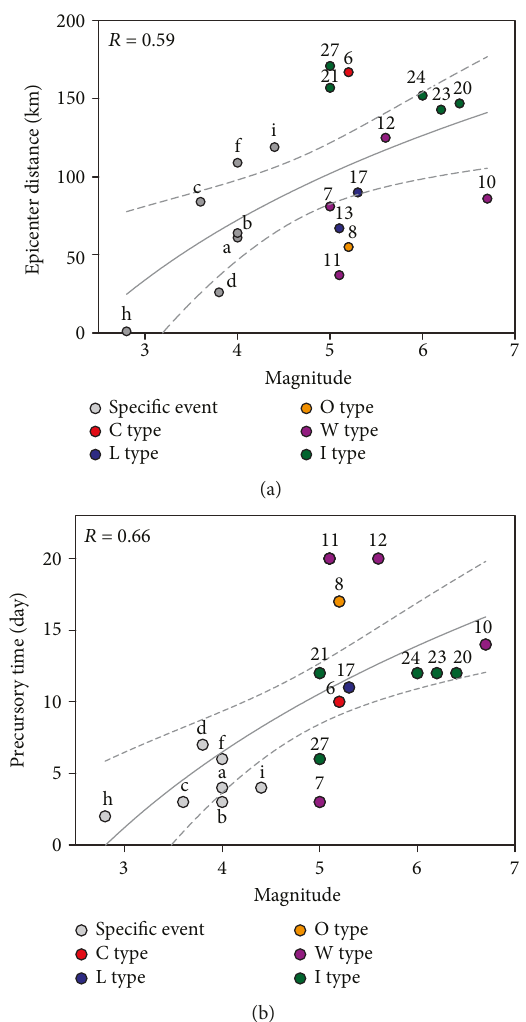
Figure 7: Variation diagrams showing the relationship between earthquake magnitude and (a) epicenter distance to the YMSG monitoring site and (b) distribution of the precursory time. Fitted curves are shown as solid lines. Dashed lines indicate the 95% con fi dence interval of the data